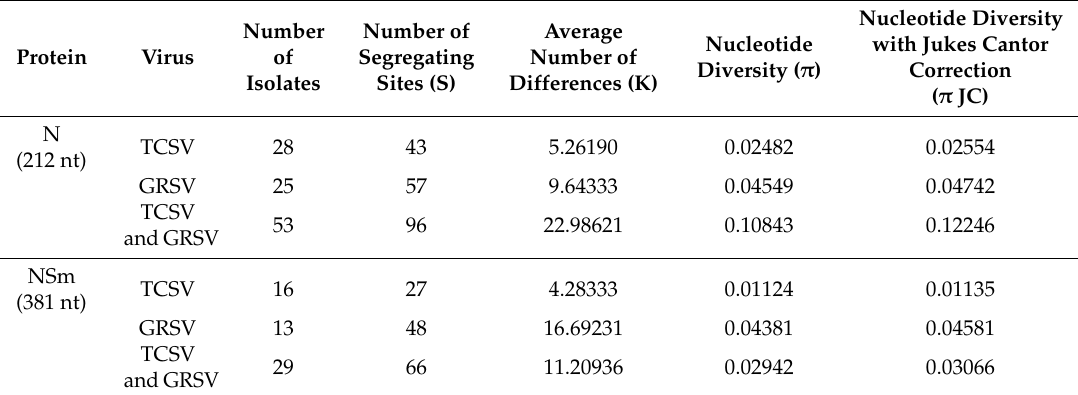
Table 1. Nucleotide diversity analysis of TCSV and